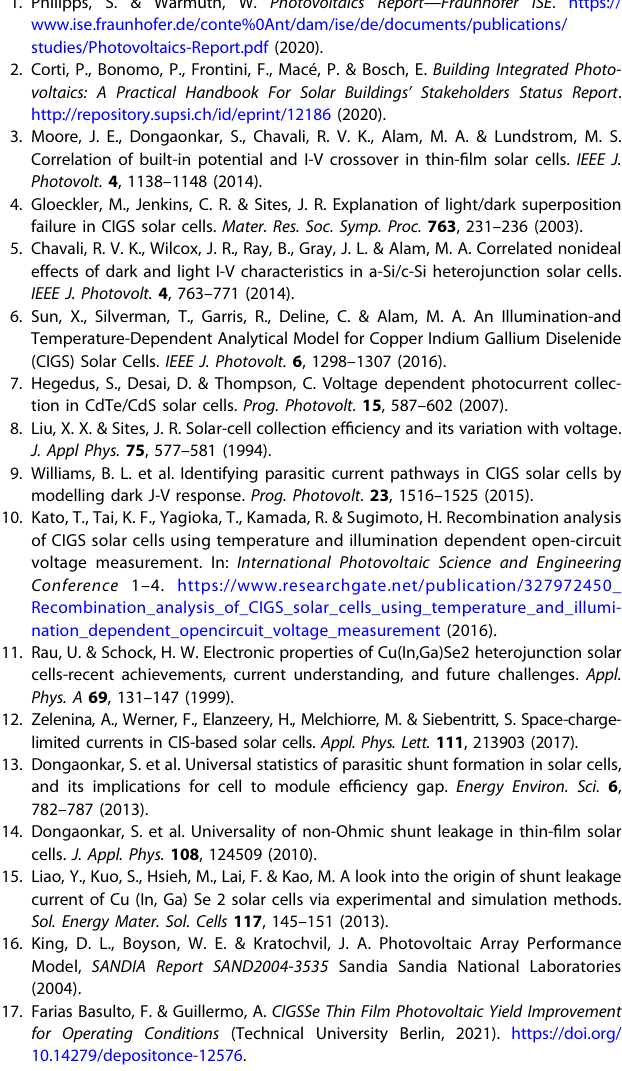
DATA AVAILABILITY